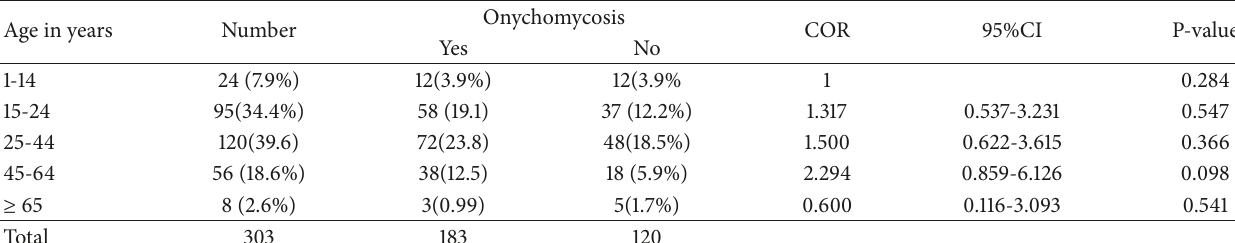
Table 3: Association of onychomycosis with age (n=303).